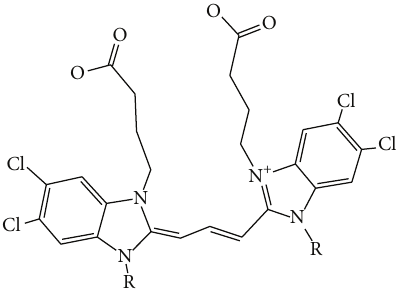
Figure 1: Chemical structure of Dye 1, where R = (CH 2 ) 8 H. Perchlorate is the counter